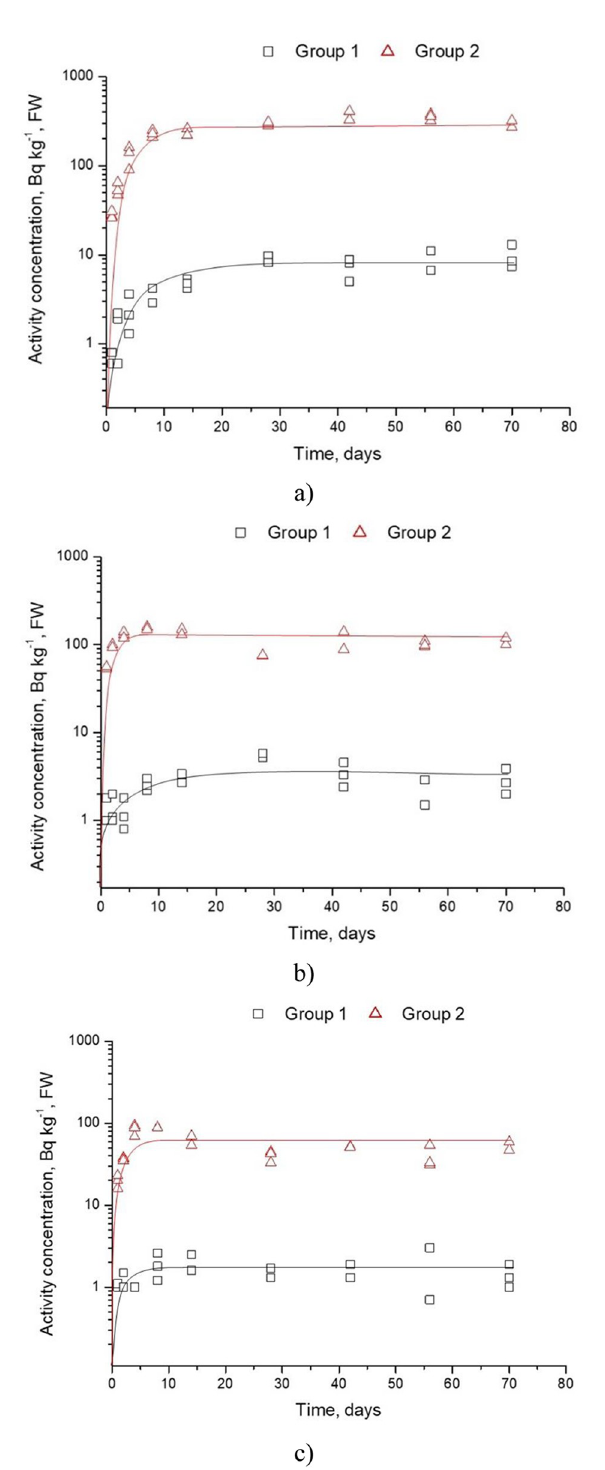
Fig 1. Mean ( ± SD) activity concentrations of 137 Cs in the muscle (a), liver (b) and bone (c) during long term intake, Bq kg -1 , FW (The analytical error of measurements no more than 10%).